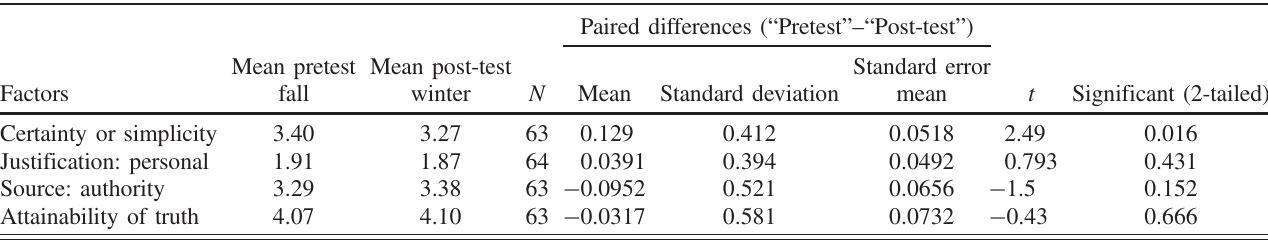
TABLE X. The results of paired t test for the experimental group at the end of the winter semester 2015 compared to the end of the fall semester 2014 (pretest).